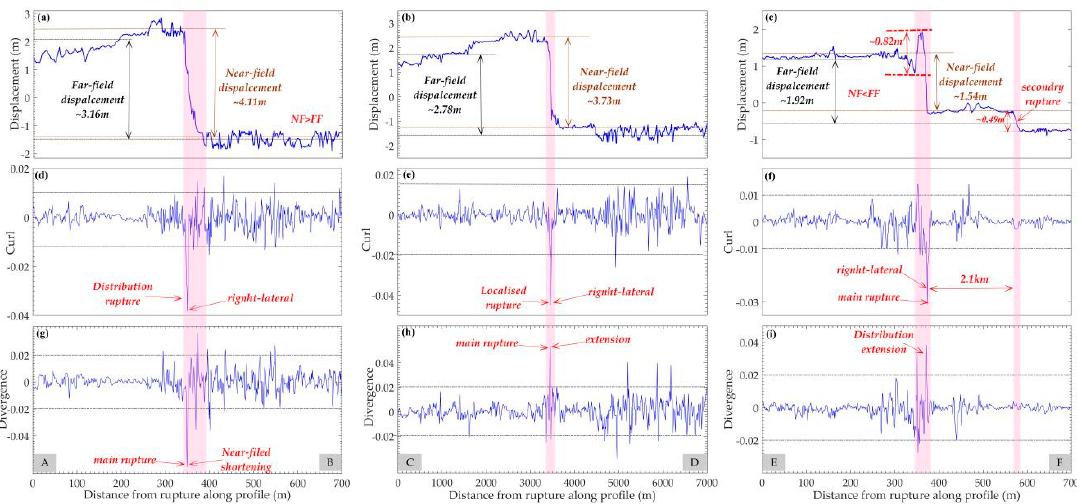
Figure 7. Near-field and far-field measurements. ( a – c ) Horizontal displacement measurements along profiles AB, CD, and EF (7-km-long and 200-m-wide) of Figure 5, respectively. ( d – f ) Curl profiles (AB, CD, and EF) show three peaks, corresponding to the main rupture at the site. In both cases, curl delineates the fault trace clearly, and the right-lateral strike-slip motion results in clockwise rotation at the fault and hence negative curl ω . ( g – i ) Divergence profiles (AB, CD, and EF) reveal three positive peaks ( δ > 0), corresponding to net extension at the fault.